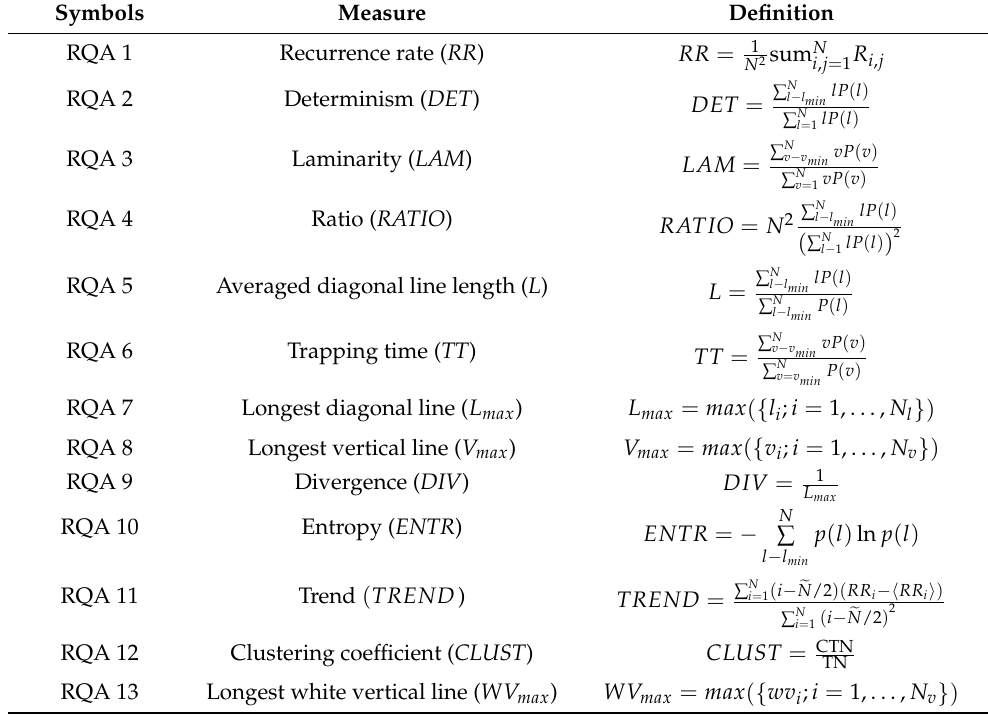
Table 1. The definition of 13 RQA